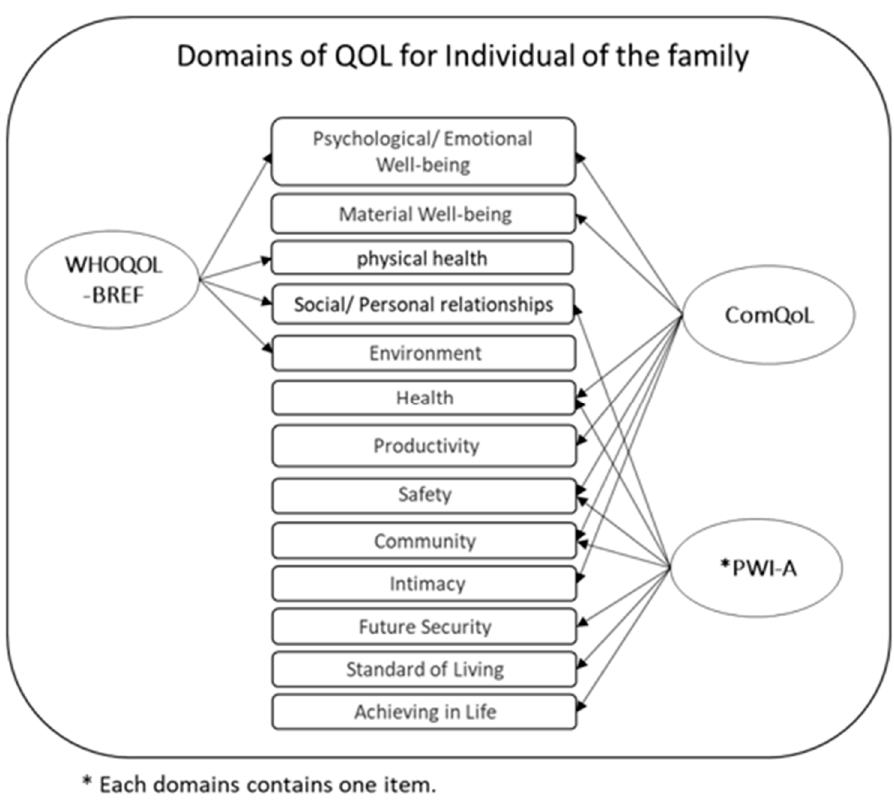
Figure 5. Domains used in the QoL scales for each family member.